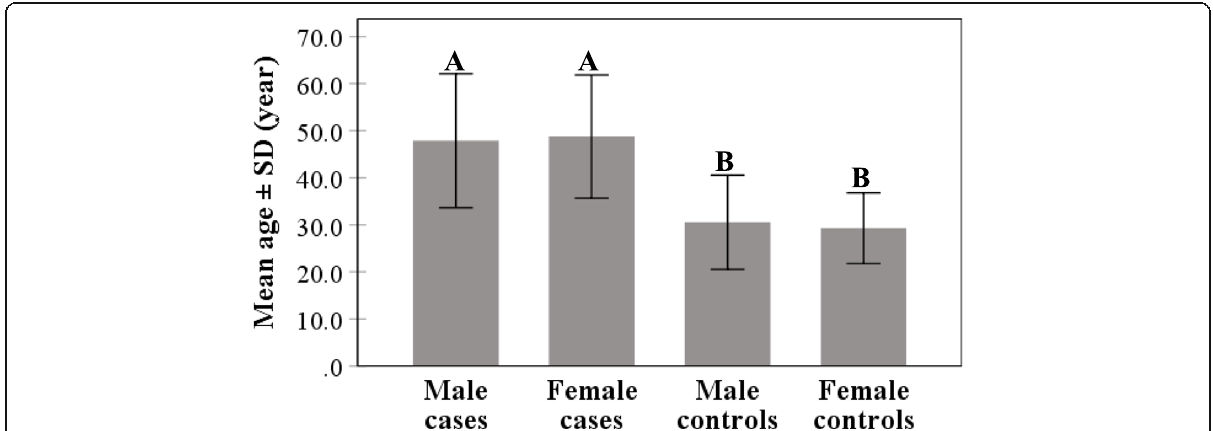
Fig. 2 Mean age of COVID-19 cases and control distributed according to gender. Different letters denote significant difference between means of bars ( p < 0.001), while similar letters denote no significant difference ( p > 0.05) (Duncan ’ s multiple range test)